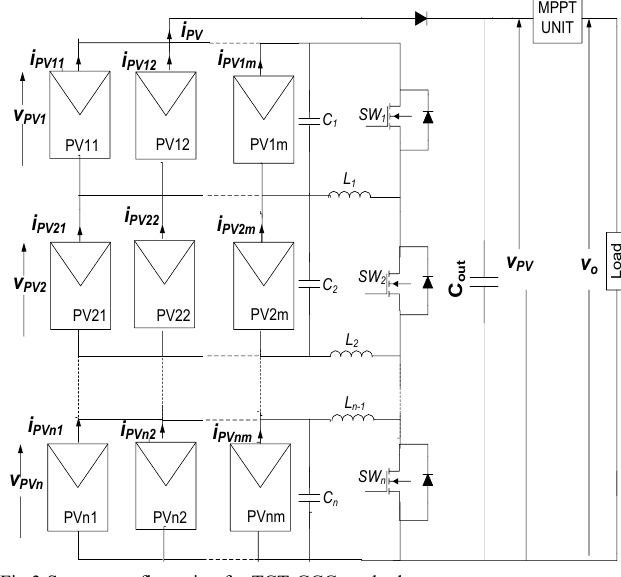
Fig 3 System configuration for TCT-GCC method The relationship between the voltage across each PV module and the off-duty ratios of each switches of the TCT- GCC are expressed in